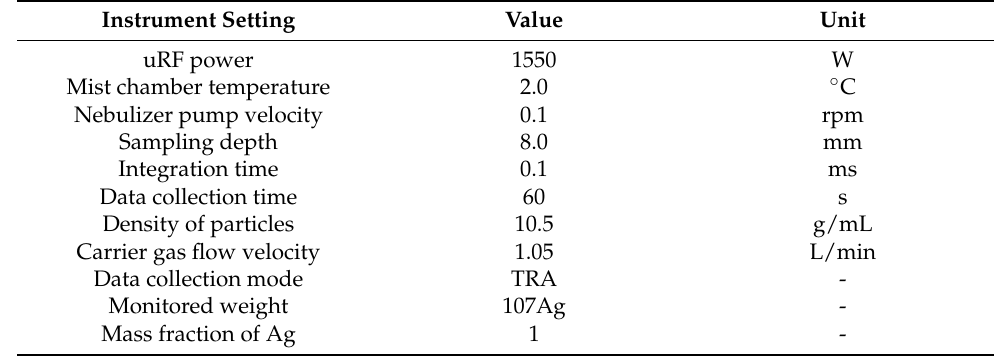
Table 1. Analysis parameters and instruments settings used during the silver nanoparticle (AgNP) characterization.